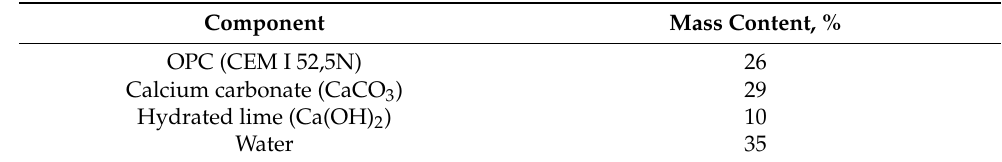
Table 2. Composition of cement buffer mixture NRVB [26].